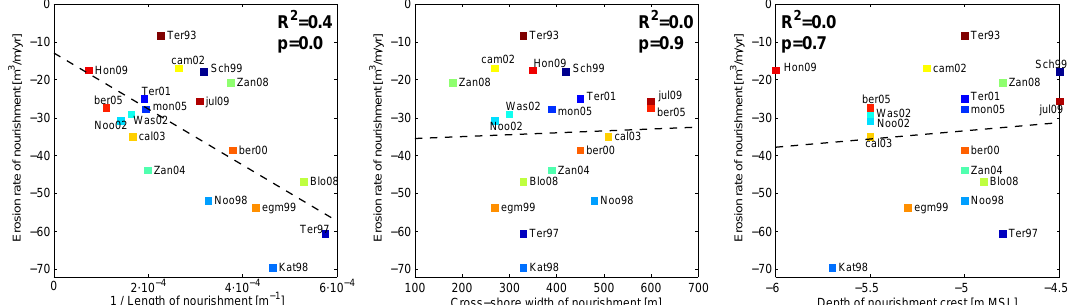
Figure 9. Correlation of the erosion rate of the nourishment region with geometrical properties of the shoreface nourishment (i.e., alongshore length, width and depth of the nourishment